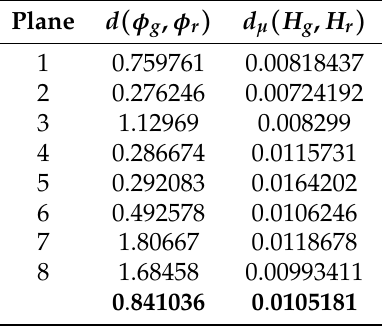
∑ (cid:104) p t , n s (cid:105) − d s p t ∈ H t | H t |